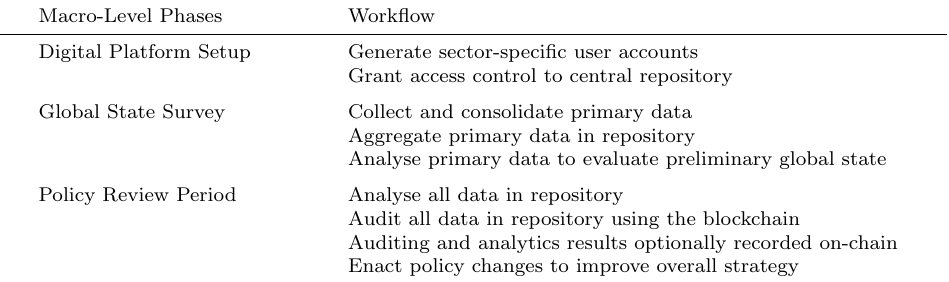
Table 2: The model workflow for the macro-welfare